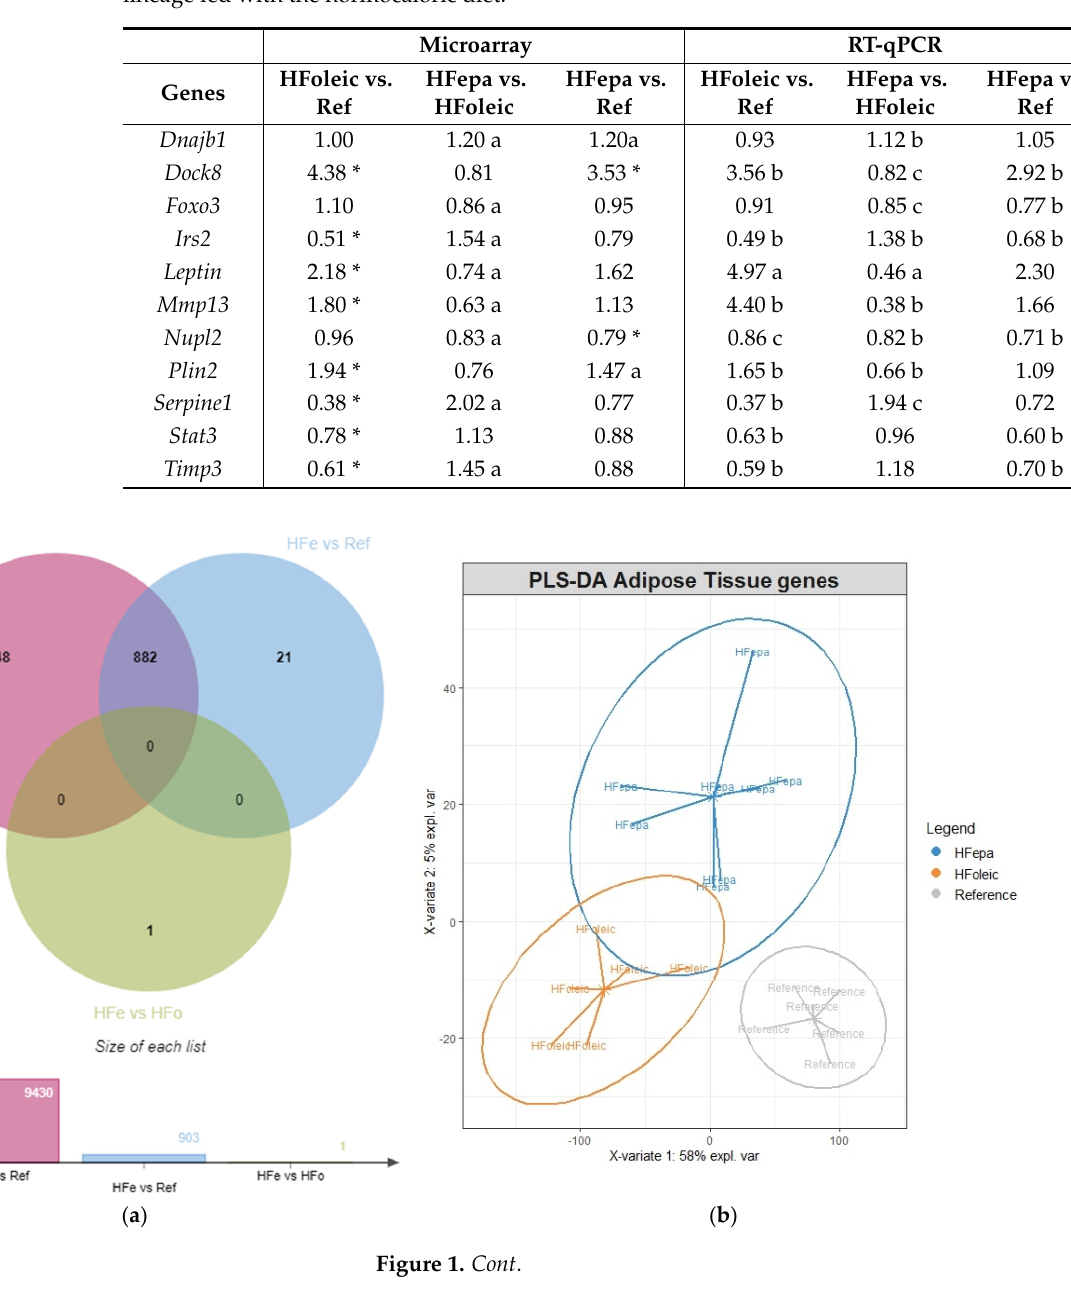
Table 1. Comparison of VAT’s gene expression data in microarray and RT-qPCR measurements. Values are mRNA level ratio between the different groups ( n = 6/8 per group). Microarray experi- ments identified significant differential expression with p < 0.05 with FDR correction (*) or no FDR correction (a). RT-qPCR validation experiments identified significant differential expression with p < 0.05 (b) or p < 0.1 (c). HFoleic, mice from oleic/control lineage fed with the obesogenic diet; HFepa, mice from EPA/omega 3 lineage fed with the obesogenic diet; Ref, mice from oleic/control lineage fed with the normocaloric diet.